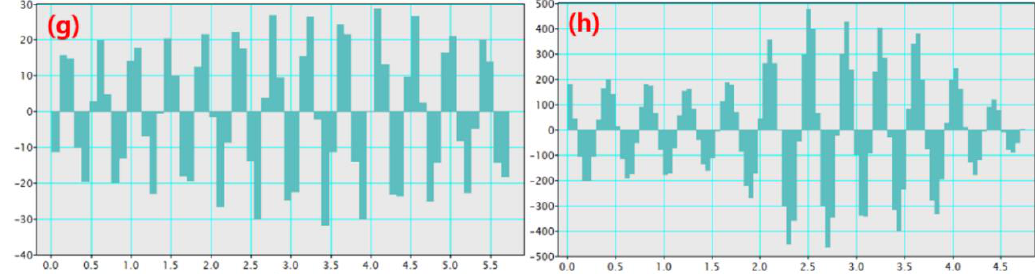
Figure 4. HRTEM of Mo 2 C@CNT hybrid: ( a – c ) Typical HRTEM images with different magnifications; ( d ) FFT pattern; ( e ) iFFT pattern and ( g ) phase profile for Mo 2 C lattices; and ( f ) iFFT pattern and ( h ) phase profile for CNT lattices.